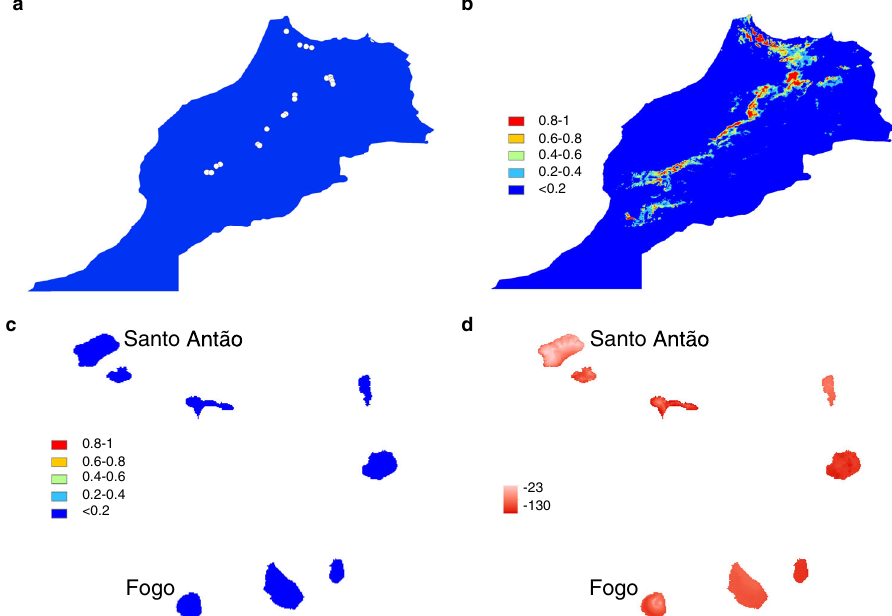
Fig. 4 Moroccan and CVI predicted distributions. a Moroccan A. thaliana occurrence locations and ( b ), predicted climate envelope within Morocco. In ( b , c ) colours represent the predicted probability of occurrence and habitat suitability, with blue indicating low probability and red high. c Predicted climatic suitability for Moroccan Arabidopsis in CVI and ( d ), predicted similarity of CVI climate to the Moroccan A. thaliana climate envelope expressed as a percentage of how dissimilar each point is in relation to the range of values used in the model. More negative (red) values indicate higher dissimilarity relative to Morocco. Maps were produced using ESRI